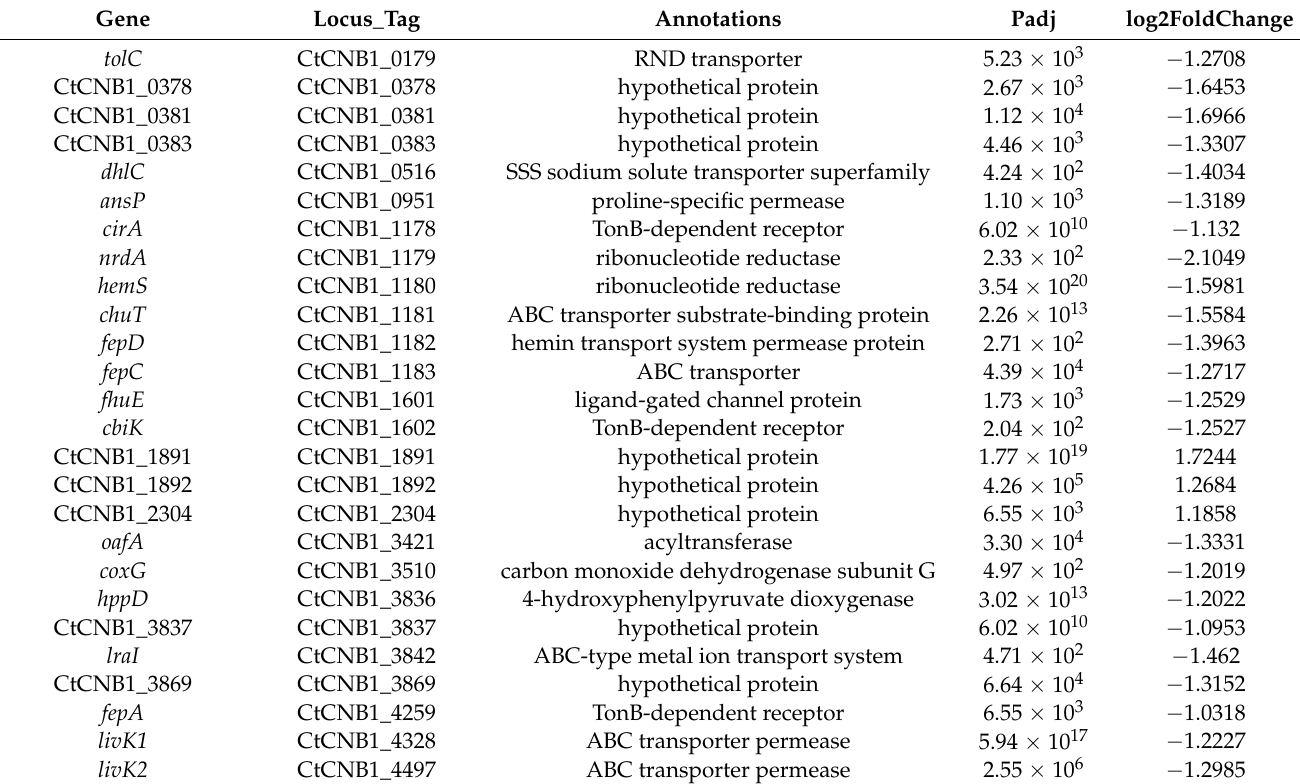
Table 3. Genes that show significant and >2-fold change at the transcriptional level in C. testosteroni strain CNB-1/Ov flmD